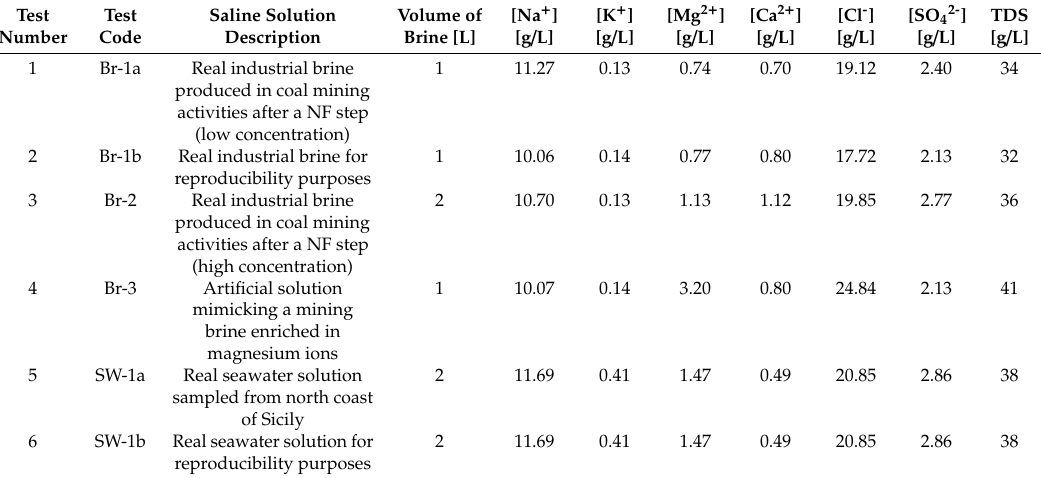
Table 2. Summary of the experimental tests carried out in the present